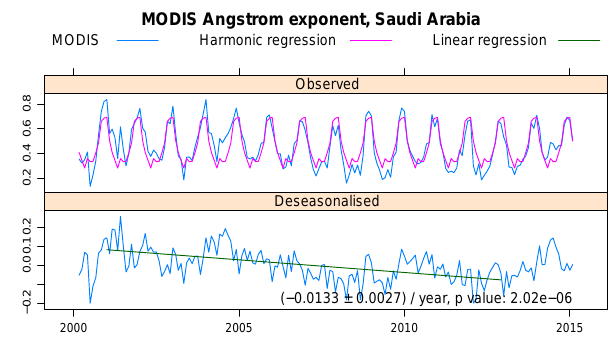
Figure 5. Evolution of the average Saudi Arabian Ångström ex- ponent from March 2000 to February 2015. Monthly values from MODIS Terra Deep Blue, collection 6, are shown. Deseasonali- sation and trend analysis are performed as for Fig. 3; see also Figs. S35 and S36 in the Supplement.